Question: Which visualization type does this figure use?
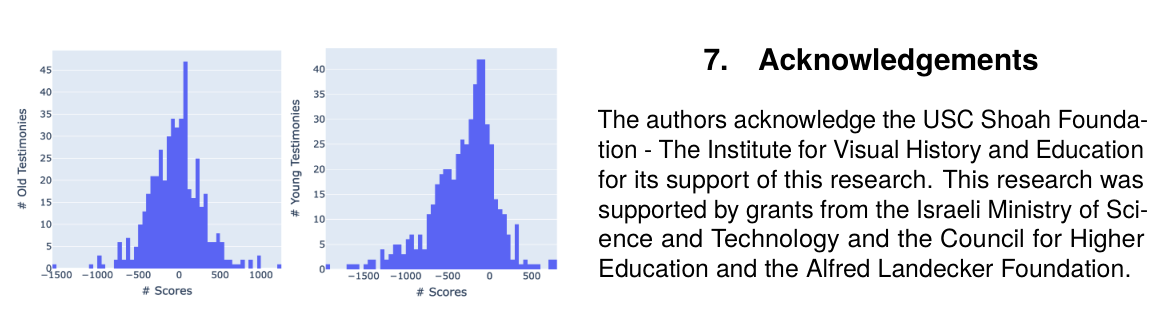
Answer: histogram